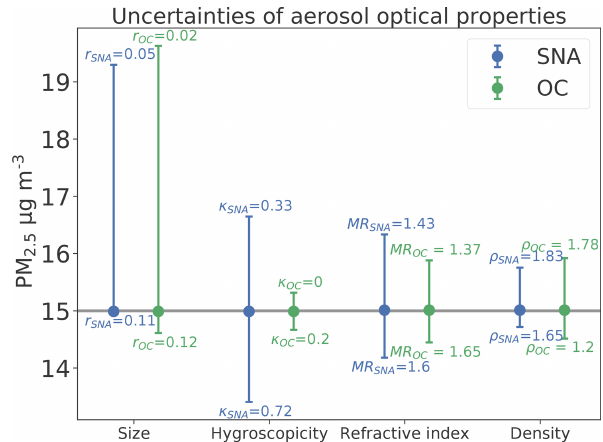
Figure 10. Uncertainties in annual average satellite-derived PM 2 . 5_MAIAC due to uncertainties of size distribution, hygro- scopicity, refractive index, and aerosol species density of sulfate– nitrate–ammonium (SNA; blue) and organic carbon (OC; green) sampled over AQS sites. The circle shows the annual average satellite-derived PM 2 . 5_MAIAC using the default parameters to cal- culate AOD CMAQ in FlexAOD (Table 1). The error bars represent the range of PM 2 . 5_MAIAC using different values for each param- eter. The labels indicate the corresponding minimum or maximum parameter values that produce the range shown in PM 2 . 5_MAIAC . The horizontal line at 15µgm − 3 indicates the annual average PM 2 . 5_MAIAC calculated using default values for each aerosol op- tical property in the base